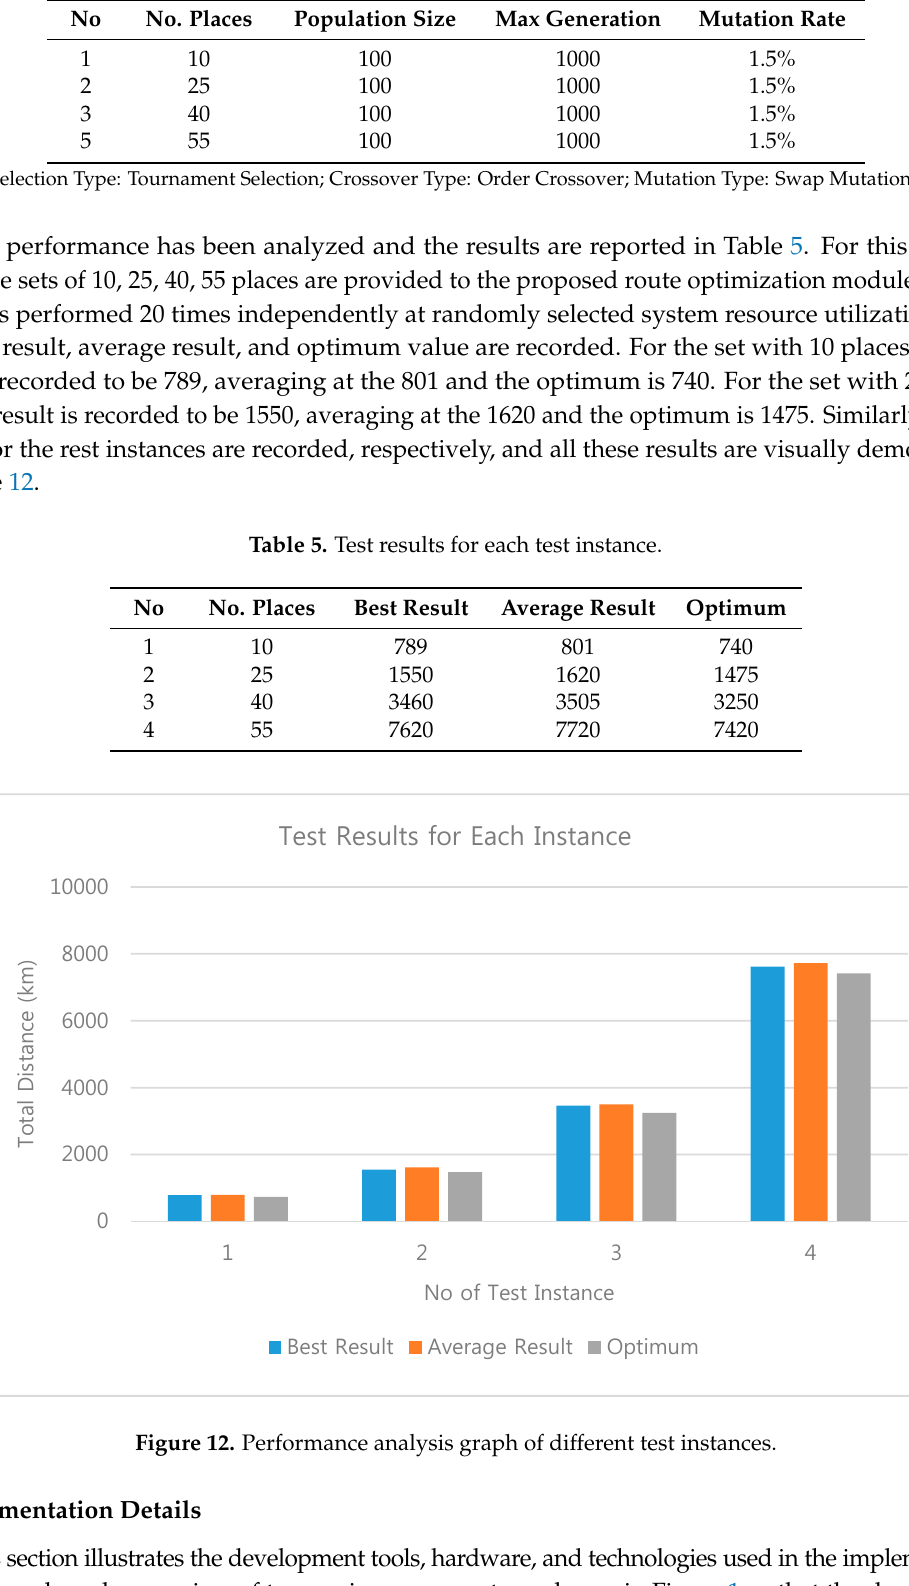
Table 4. Test agenda for travel route optimization.